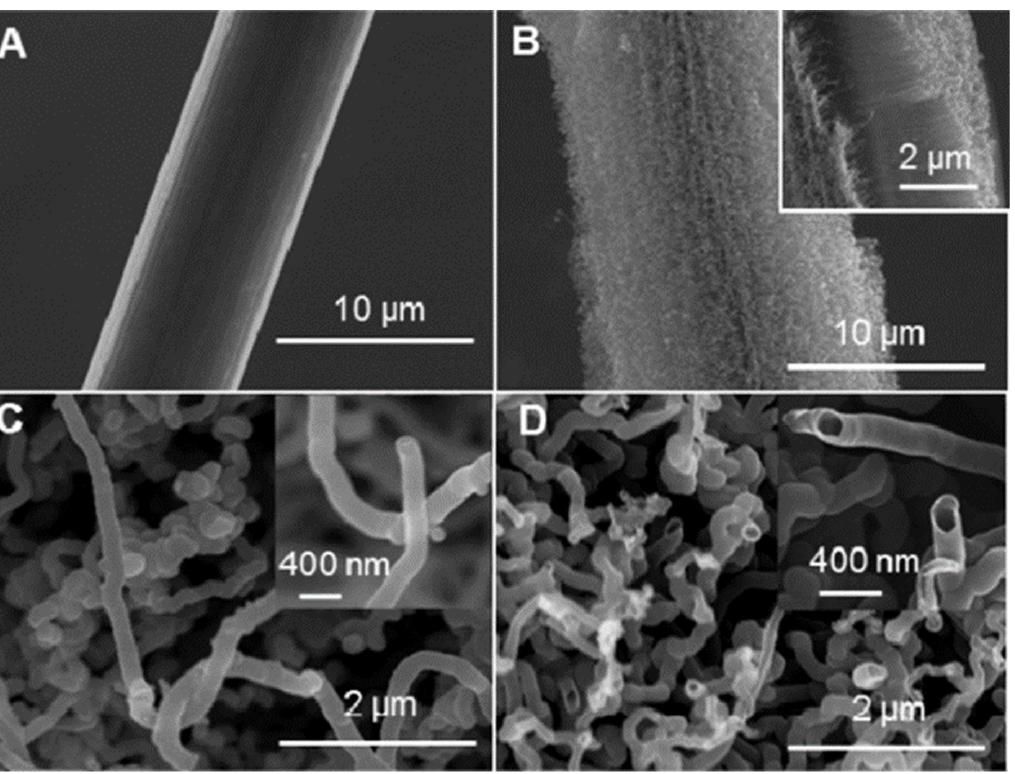
Figure 3. SEM images of ( A ) CF, ( B ) VACNT-CF, and the tips of VACNT-CF ( C ) before and ( D ) after electrochemical treatment in 1.0 M NaOH. Reprinted with permission from [26]. Copyright 2014 American Chemical Society.